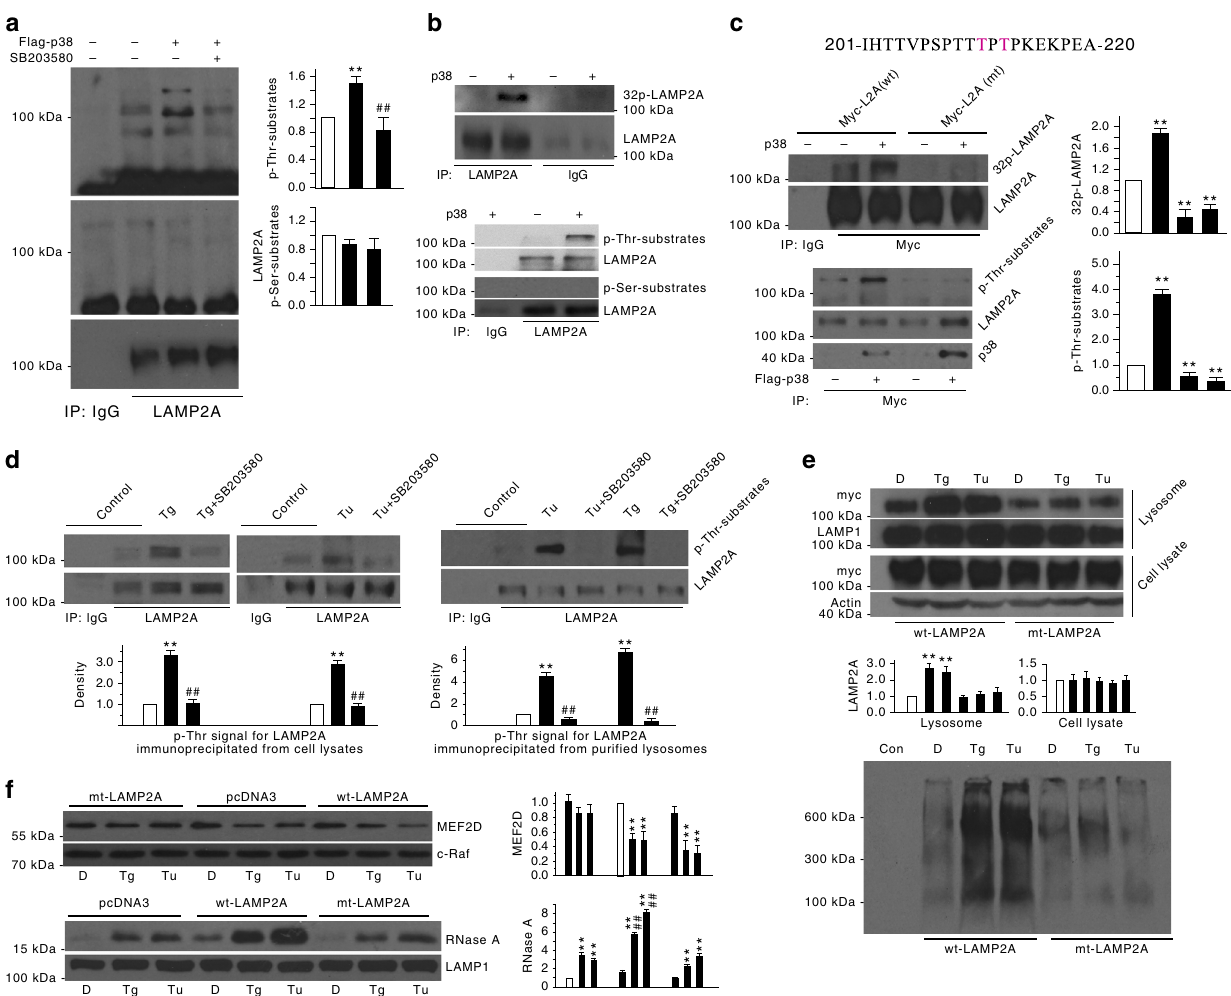
Fig. 4 p38 MAPK directly phosphorylates LAMP2A. a High level of p38 MAPK leads to LAMP2A phosphorylation in SN4741 cells. SN4741 cells were transfected with p38 MAPK for 40 h with or without SB203580 (20 μ M), and proteins were collected for IP with anti-LAMP2A and IB with antibodies to p-Thr-substrates, p-Ser-substrates, or LAMP2A. b p38 MAPK directly phosphorylates human LAMP2A in vitro. Endogenous LAMP2A proteins were immunoprecipitated from HEK293 cells, and the precipitates were incubated with puri fi ed p38 MAPK in vitro kinase assay with 32 P-ATP or cold ATP following by anti-p-Thr or p-Ser blotting. ( c ) T211 and T213 are required for p38 MAPK-mediated phosphorylation of LAMP2A. HEK293 cells were transfected with myc-LAMP2A (wt) or (mt, T211A and T213A) for 40 h, and proteins were collected for IP with anti-myc for p38 MAPK in vitro kinase assay (top left); and SN4741 cells were transfected with LAMP2A (wt), or LAMP2A(mt) with Flag-p38 MAPK for 40 h and proteins were collected for IP with anti-myc and IB with anti-p-Thr-substrate antibody. d ER stress induces LAMP2A phosphorylation in a p38 MAPK-dependent manner. SN4741 cells were treated with Tg (0.3 μ M) or Tu (3 μ g/ml) for 2 or 1 h, respectively. Total (top) or lysosomal (bottom) proteins were extracted from the cells for IP with LAMP2A antibody and IB with anti-p-Thr-substrate antibody. e ER stress increases lysosomal LAMP2A and its oligomerization in a phosphorylation-dependent manner. SN4741 cells were transfected with myc-wt-LAMP2A or myc-mt-LAMP2A (T211A and T213A) for 24 h and then were treated with Tg (0.3 μ M) or Tu (3 μ g/ml) for 12 h. Lysosomal proteins were blotted following SDS-PAGE (top) or blue negative gel (bottom) with anti-myc antibody. f ER stress increases CMA activity in an LAMP2A phosphorylation-dependent manner. SN4741 cells were transfected with pcDNA3, wt-LAMP2A, or mt-LAMP2A (T211A and T213A) for 24 h and then were treated with Tg (0.3 μ M) or Tu (3 μ g/ml) for 12 h. Cytoplasmic proteins were blotted with an MEF2D antibody (top), and intact lysosomes were assessed in uptake assay (bottom). Quanti fi cations are shown for a , c , d , e , and f ( n = 3. All values are mean ± s.d. (ANOVA with Turkey test). ** p < 0.005 vs. control and ## p < 0.005 vs. corresponding challenge